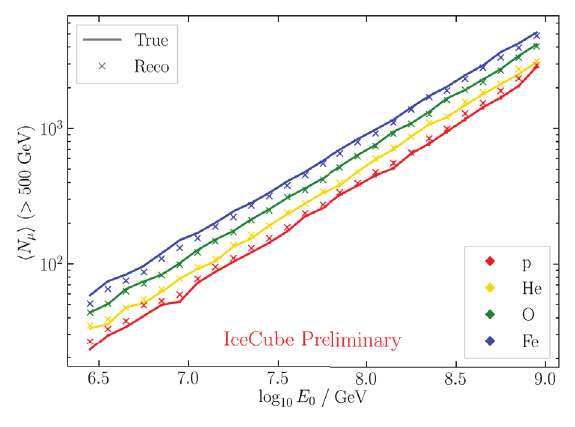
Figure 9: Average muon multiplicity (cid:4) N μ (cid:5) ( > 500 GeV) as a function of primary energy in simulation obtained using the neural network determination of N μ and E 0 compared to the true values for several elementary groups [12].